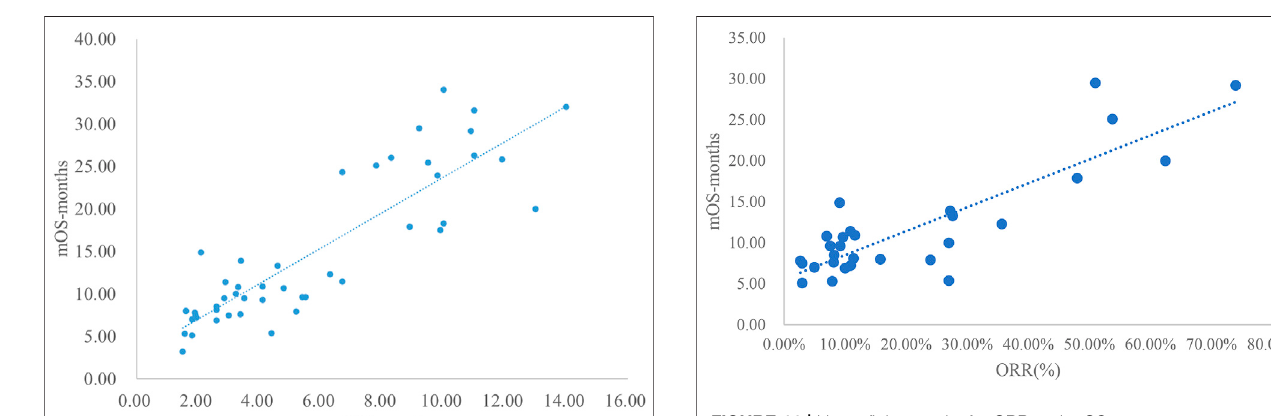
FIGURE 11 | Linear fi tting results for ORR and mOS.